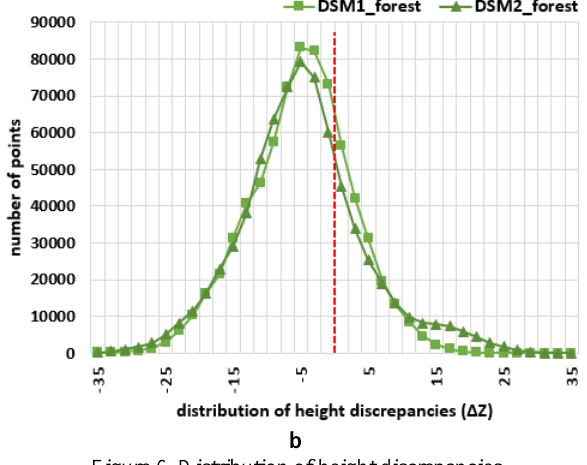
Figure 6. Distribution of height discrepancies (a= built-up, b= forest)